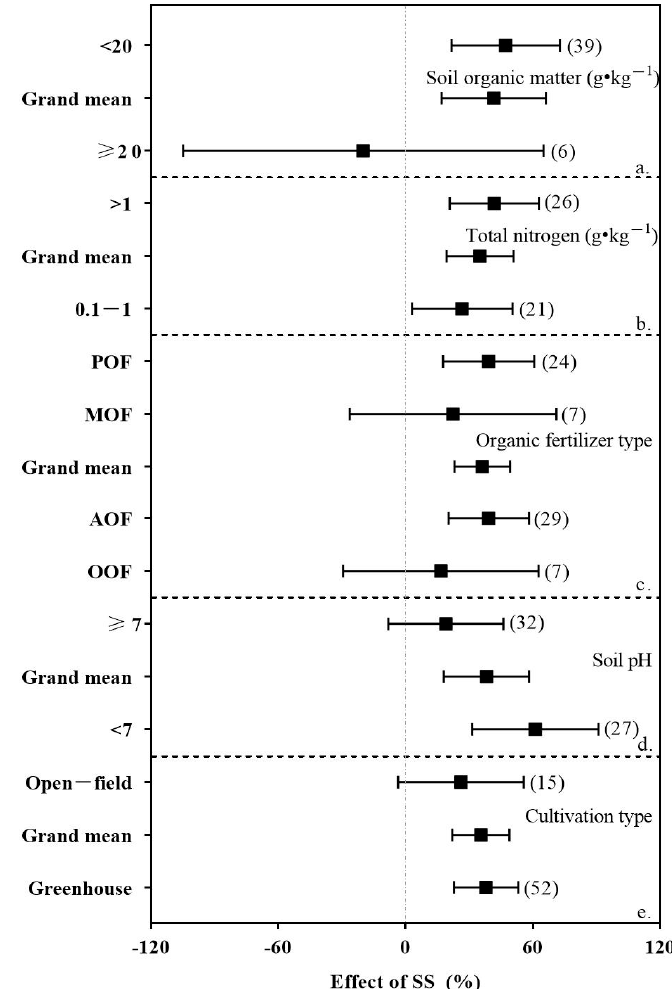
Figure 6. Organic fertilizers combined with soil organic matter ( a ), total soil nitrogen ( b ), type of organic fertilizers ( c ), soil pH ( d ), and cultivation type ( e ) on tomato SS (soluble sugar) percentage changes. Points represent the mean effect, while bars represent 95% confidence intervals. The numbers on the right side of the confidence intervals represent the sample sizes. AOF, animal organic fertilizer; MOF, mixed animal-and-plant organic fertilizer; POF, plant organic fertilizer; OOF, other organic fertilizer.